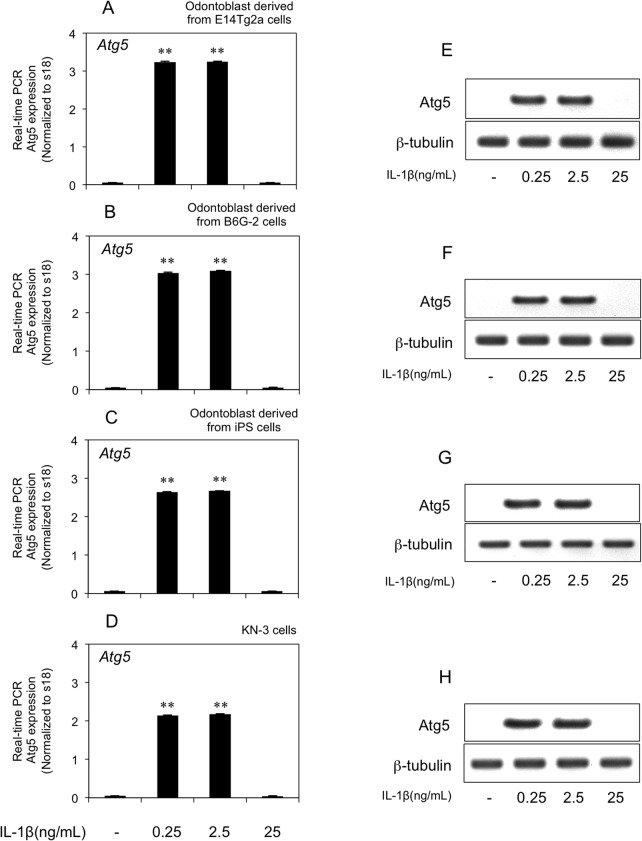
IL-1β-induced expression of Atg5 mRNA and protein in odontoblast-like cells.Two stem cell-derived odontoblast-like cell lines and an odontoblast cell line (KN-3) were treated with IL-1β (0, 0.25, 2.5, and 25 ng/mL). (A–D) qPCR analysis of Atg5 mRNA expression relative to the control (18S rRNA). Data are the means ± SD of four independent experiments. **P < 0.01. (E–H) Western blot analysis of Atg5 and β-tubulin protein levels following stimulation with IL-1β. Representative blots of three independent experiments are shown.